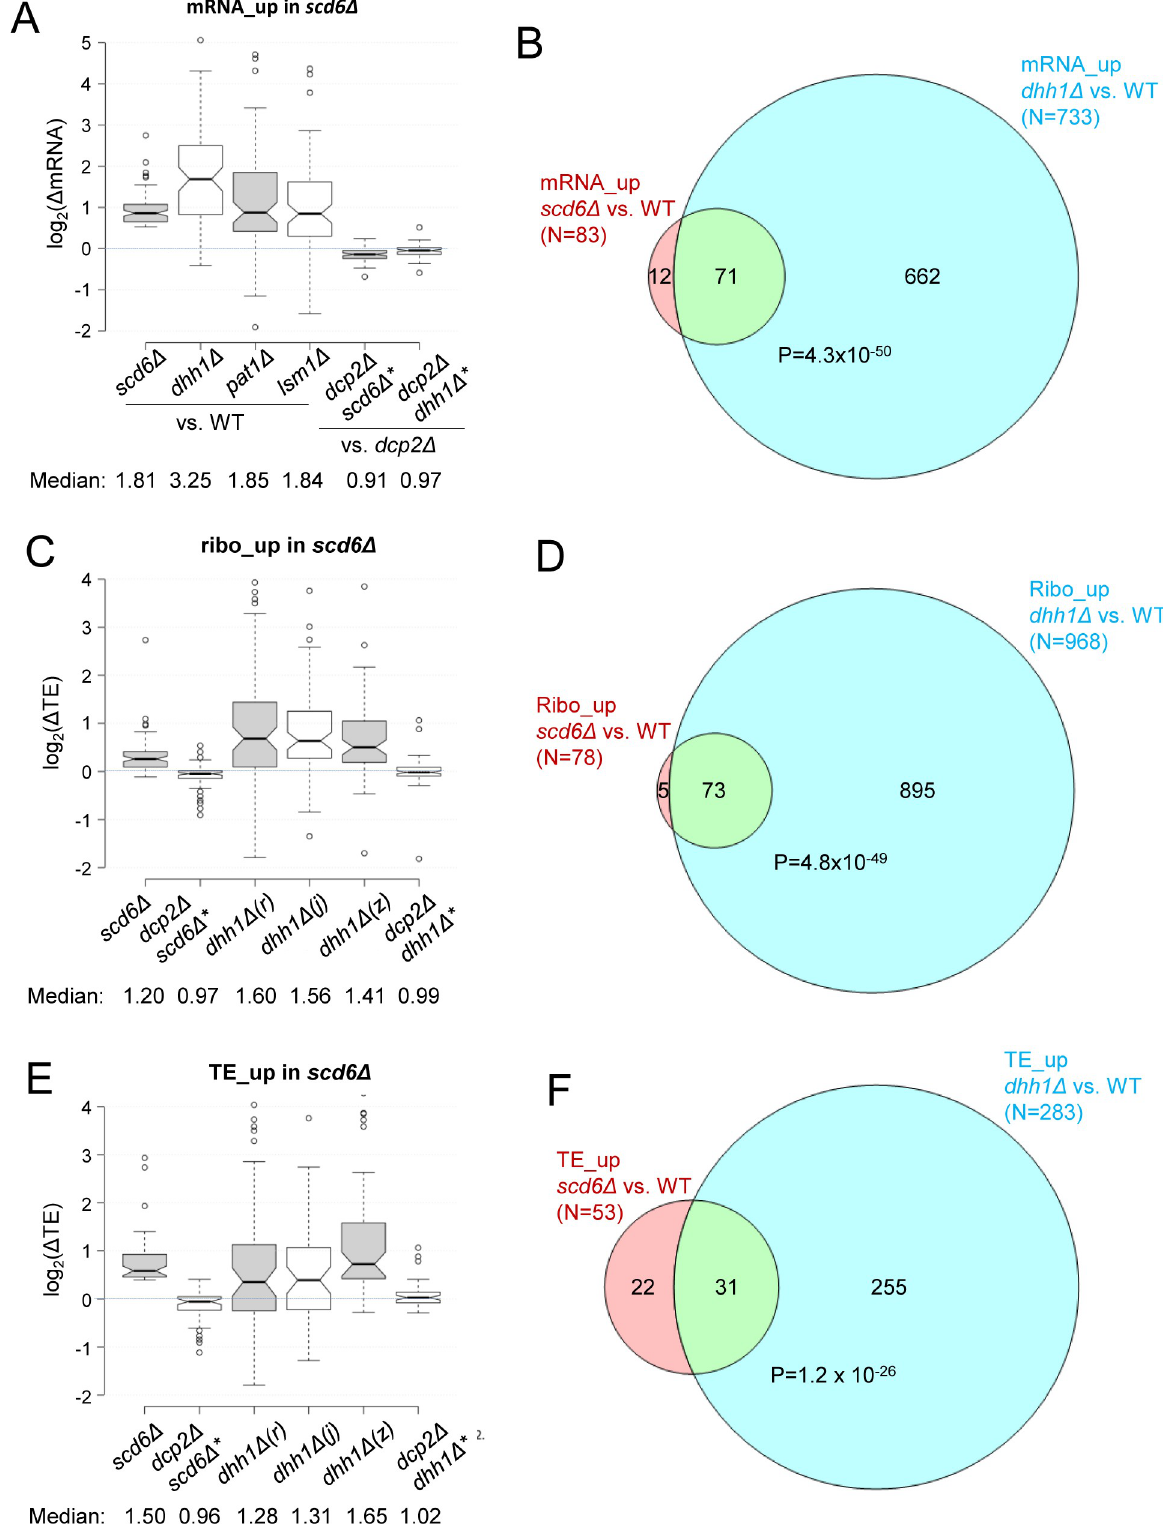
Fig 7. Scd6 and Dhh1 cooperate in repressing mRNA abundance and translational efficiencies of a subset of native mRNAs. (A) Notched box-plots of log 2 mRNA changes ( Δ mRNA) in the indicated mutants for 83 mRNAs exhibiting � 1.4-fold increased mRNA abundance in scd6